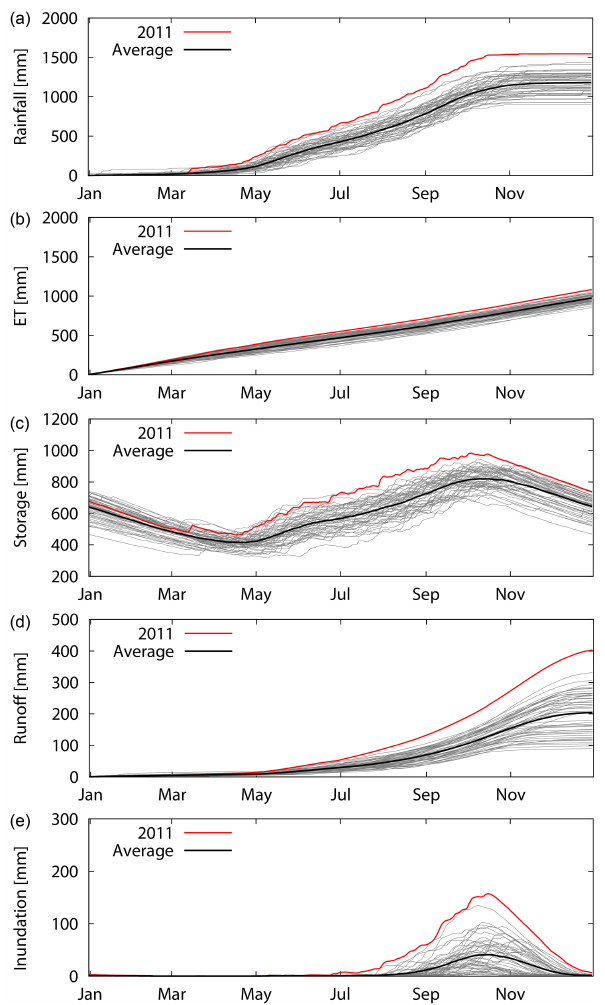
Figure 5. Simulated water balance components for 2011 (red lines), the other 51 years (grey lines) and average values (black lines) in 1960–2011: (a) cumulative rainfall, (b) cumulative evapotranspira- tion, (c) catchment storage volume, (d) cumulative runoff and (e) in- undation volume.